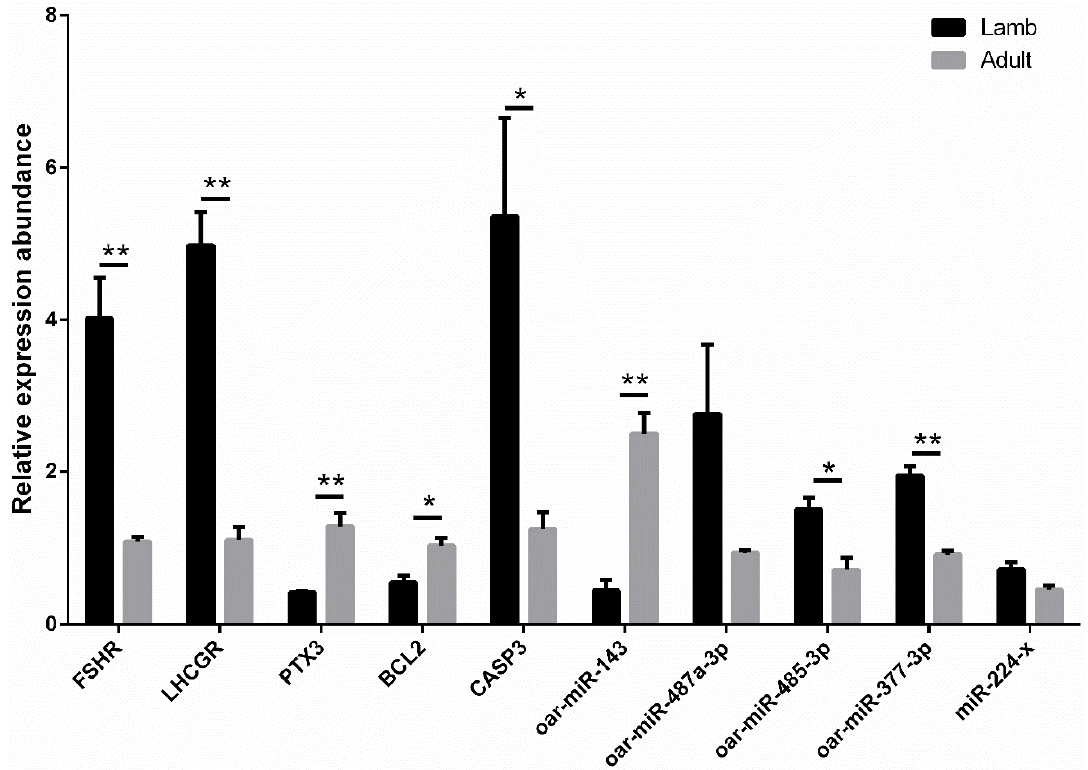
Figure 4. Real-time PCR validation of mRNA associated with hormone receptor and oocyte quality. * Significant difference at p < 0.05, ** significant difference at p < 0.01.